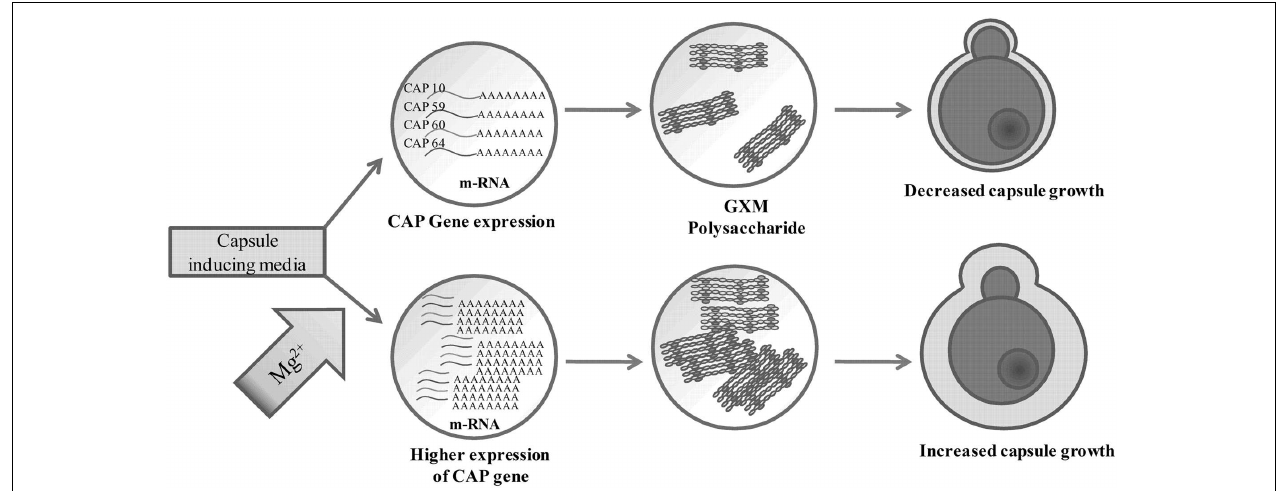
FIGURE 11 | Proposed role of Mg 2 + in capsule regulation in C.